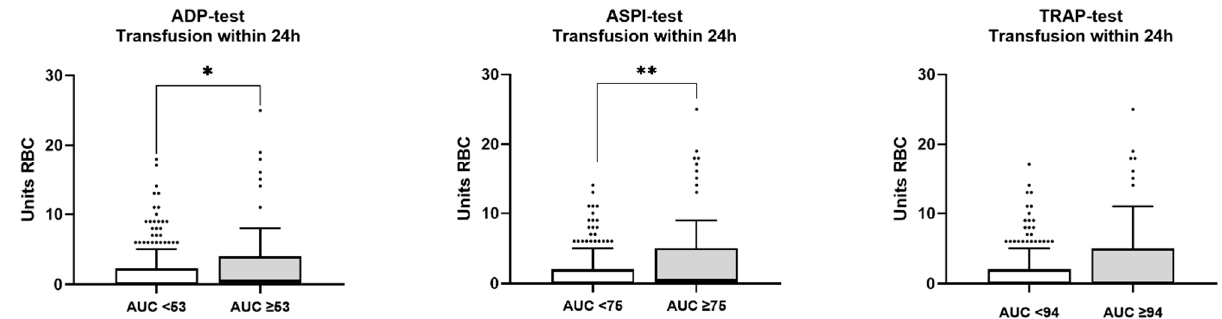
Figure 4. Multiplate tests below and within reference range and RBC transfusion in the first 24 h after hospital admission. White, normal reference range; grey, lower reference range. ADP, adenosine diphosphate; ASPI, arachidonic acid test; TRAP, thrombin receptor activating peptide; AUC, area under curve; RBC, red blood cells. * p < 0.05; ** p < 0.01; no indication = not significant. Data are presented as box and whisker plots (Tukey). Student’s t -test or Mann–Whitney rank sum test was used as appropriate for between-group comparisons.